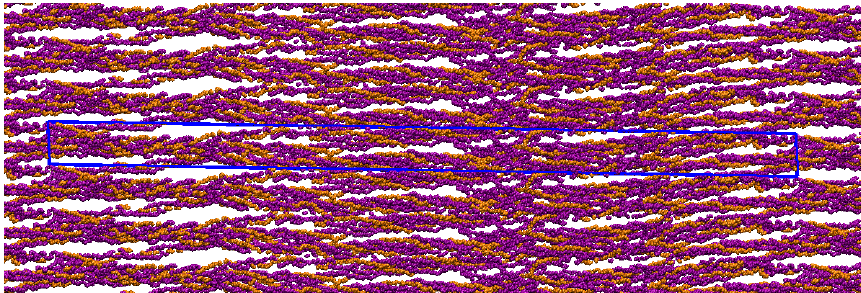
Figure 4. CLG Fibril periodically replicated in space; snapshot from VMD